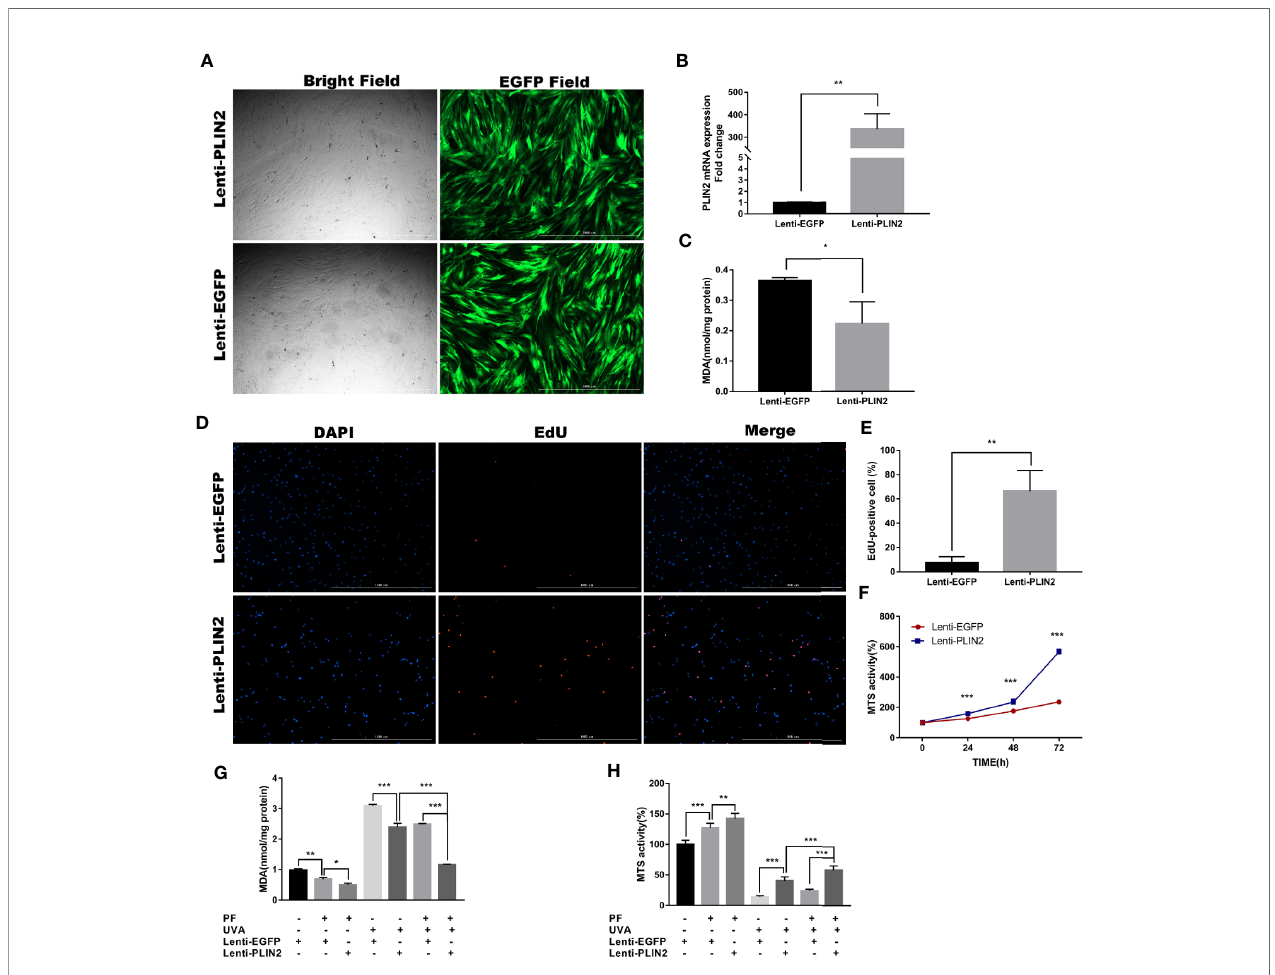
FIGURE 5 | PLIN2 overexpression had a protective role in HDFs. (A) PLIN2 transfection was con fi rmed by observing EGFP positive cells under an inverted fl uorescent microscope. (B) The transfection ef fi ciency of PLIN2 was evaluated by RT-qPCR. (C) The level of MDA in PLIN2 overexpressed cells. (D) EdU staining was observed under fl uorescence microscopy, red fl orescence indicated EdU-positive (EdU + ) cells and blue fl orescence indicated cell nucleus, respectively. (E) The percentage of EdU + cells in PLIN2 overexpressed cells. (F) The MTS activity of PLIN2 overexpressed cells and negative cells at the time points of 24, 48, and 72 h. (G) Detection of the level of MDA in cells treated with UVA+PLIN2 overexpression and/or UVA+PF-pretreatment. (H) The MTS activity of cells treated with UVA +PLIN2 overexpression and/or UVA+PF-pretreatment. All data were expressed as the mean ± SD according to at least three independent experiments. * p < 0.05, ** p < 0.01, *** p <